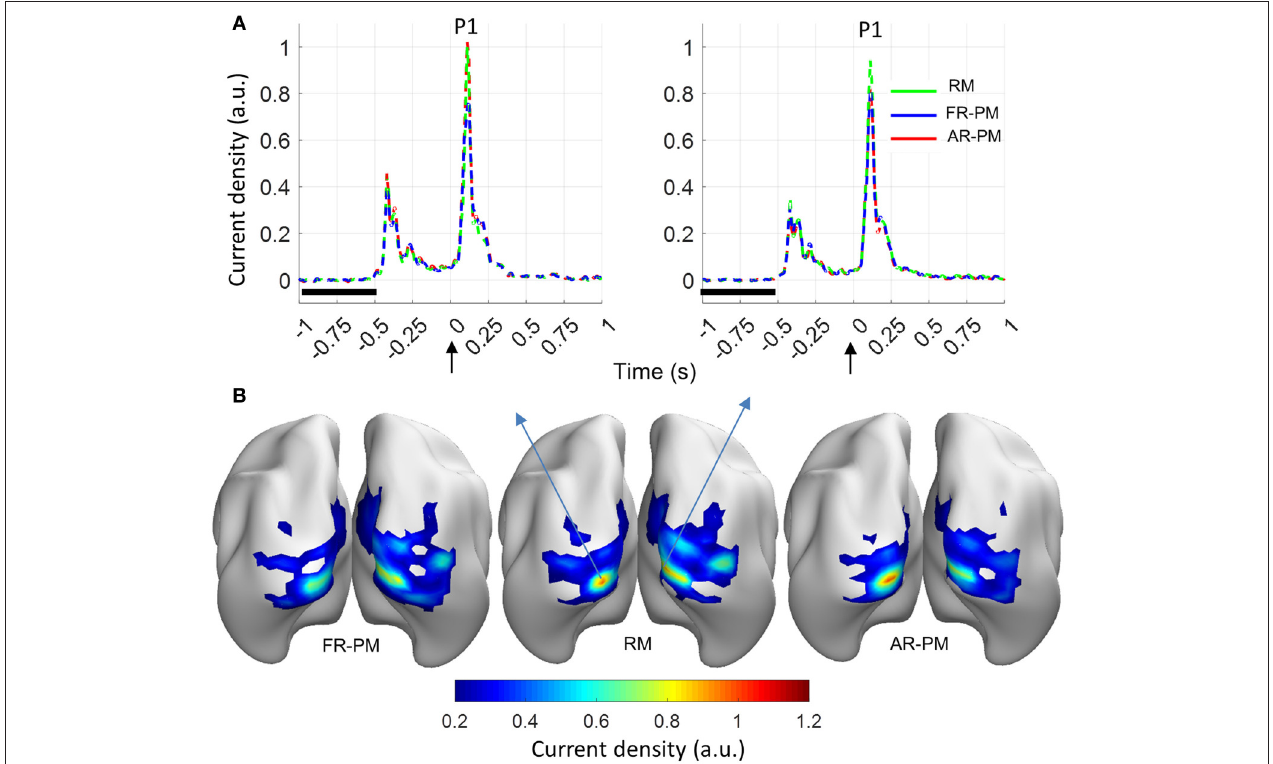
FIGURE 5 | Functional group source response (event-related power [ERP]) from visual stimulation (averaged over 100 group iterations for 20 subjects in a group). (A) ERP time series for source locations with peak source activity at latency of 0.108s (P1 peak) in left and right visual cortices. Baseline period: − 1 to − 0.5 s, Stimulus onset: 0 s. (B) Current density distribution for ERP peak (P1 component). a.u. arbitrary unit where a.u. = 1 corresponds to maximum source ERP value over the cortex for the real MRI. RM, real MRI; FR-PM, First rank pseudo MRI; and AR-PM, averaged rank pseudo